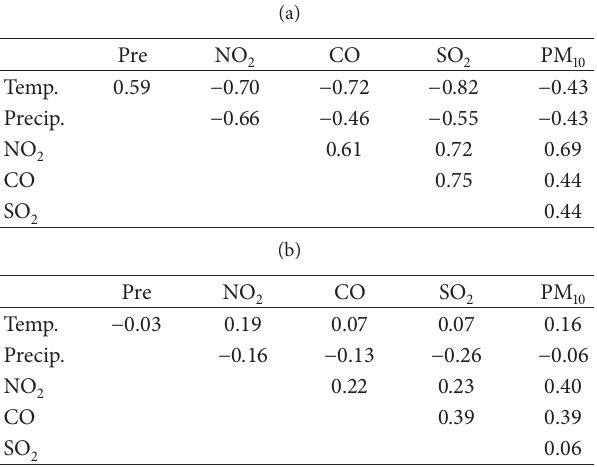
Table 2: The correlation coefficients between temperature, precipi- tation, and air pollutants: (a) with seasonal effects included and (b) with seasonal effects